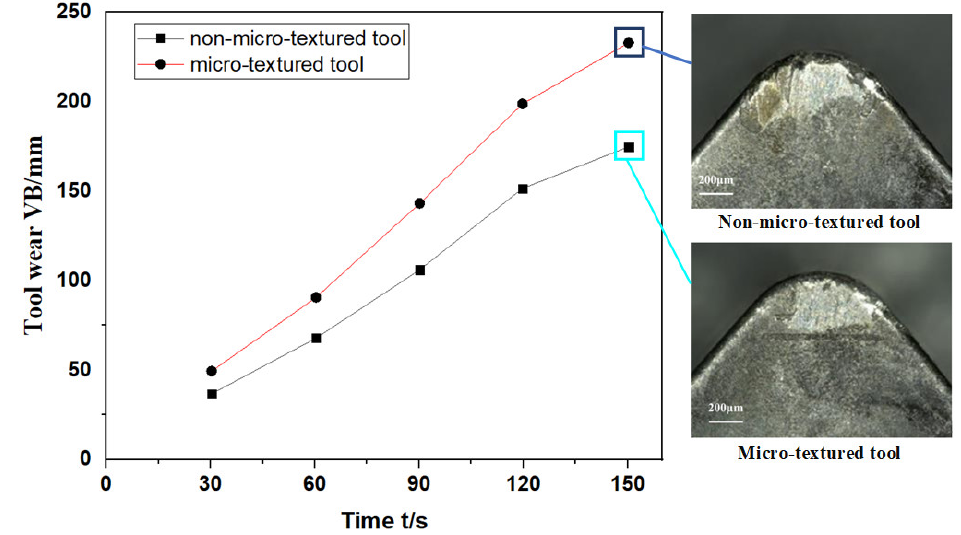
Figure 13. The wear value of different tools varies with time and the adhesion wear image.